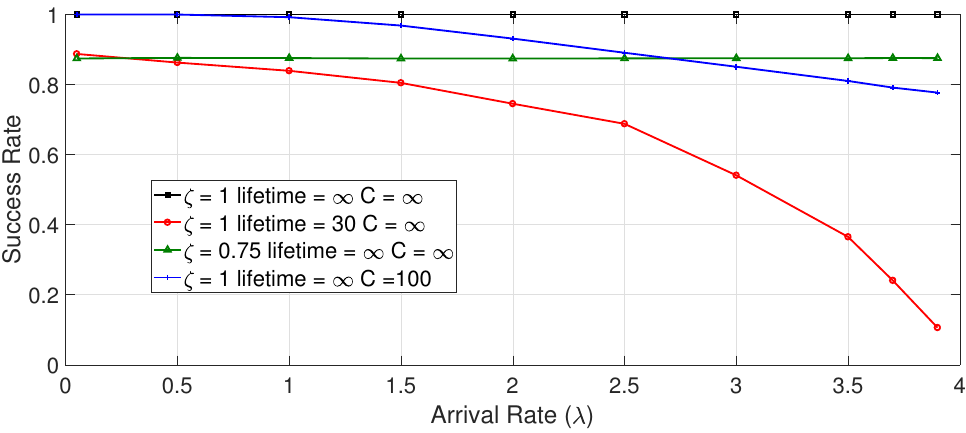
Figure 7. Success rates for various ON/OFF model